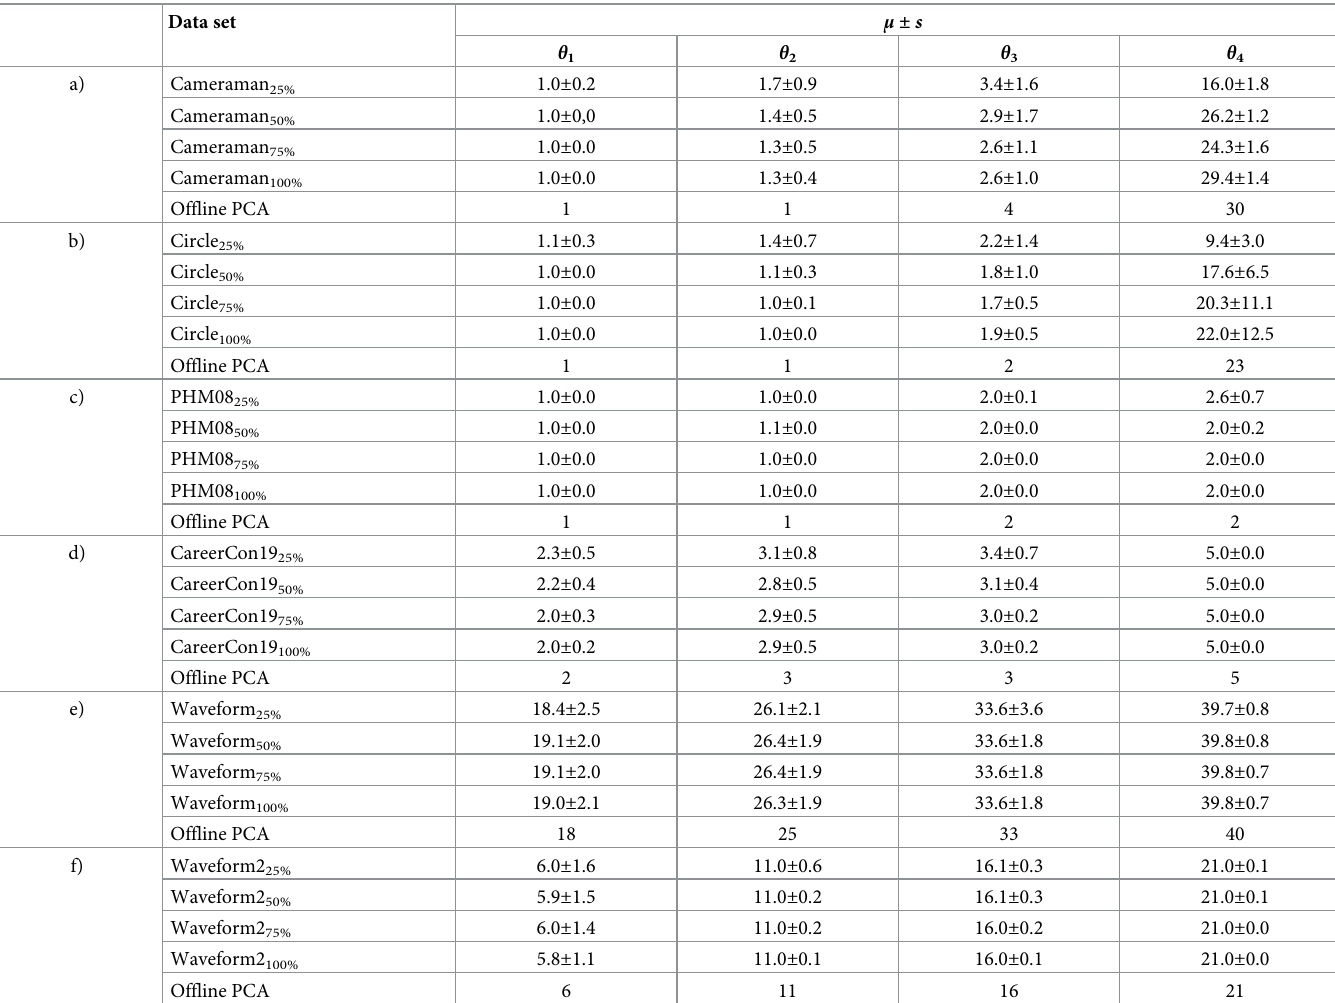
Table 5. Cumulative percentage of total variance: θ 1 = 0.7, θ 2 = 0.8, θ 3 = 0.9, θ 4 = 0.99. Data